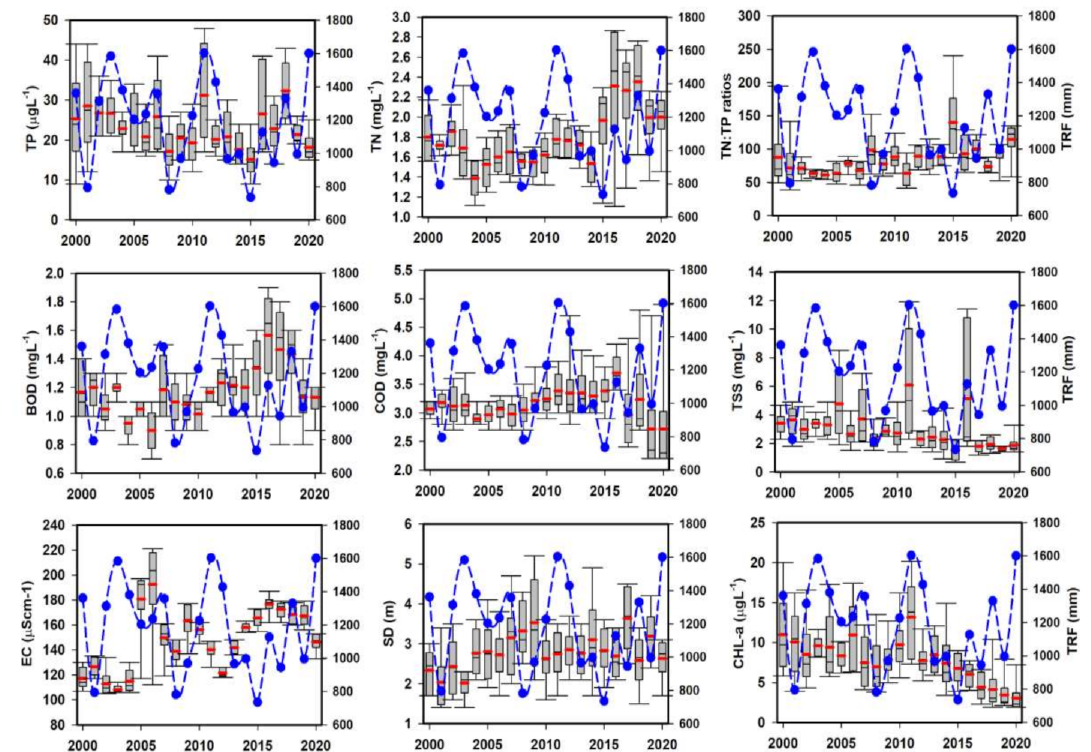
Figure 2. Inter-annual variation of salient water quality parameters. TP: total phosphorus, TN: total nitrogen, BOD: biological oxygen demand, COD: chemical oxygen demand, TSS: total suspended solids, EC: Electrical conductivity, SD: Secchi depth, CHL-a: chlorophyll-a. The blue curve line indicated the total rainfall (TRF) while the red lines indicate